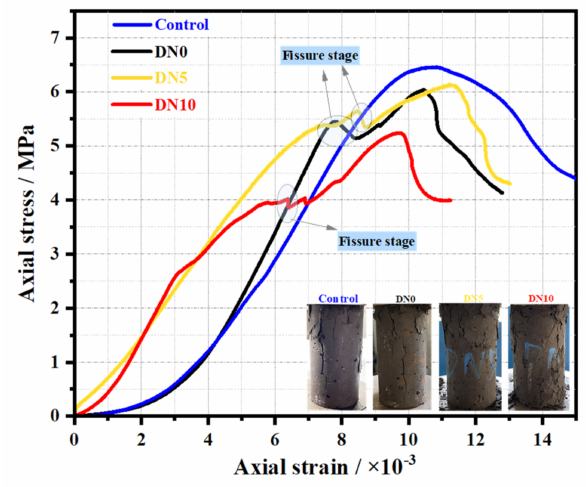
Figure 9. Stress–strain plots for specimens subjected to erosion with different